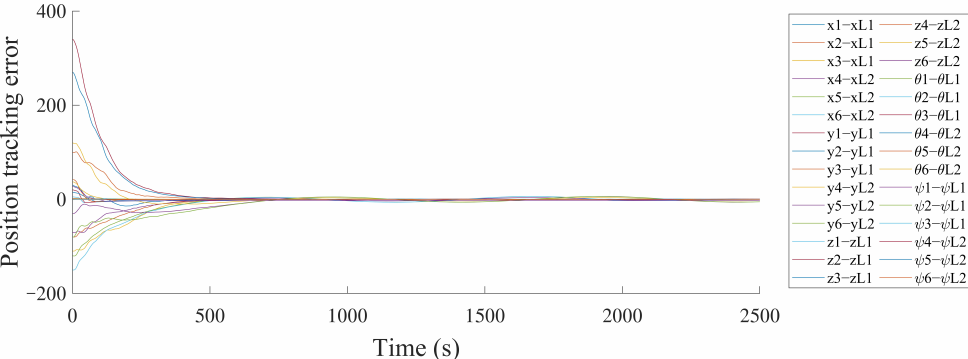
Figure 10. The position tracking errors of a multiple stochastic AUV system.